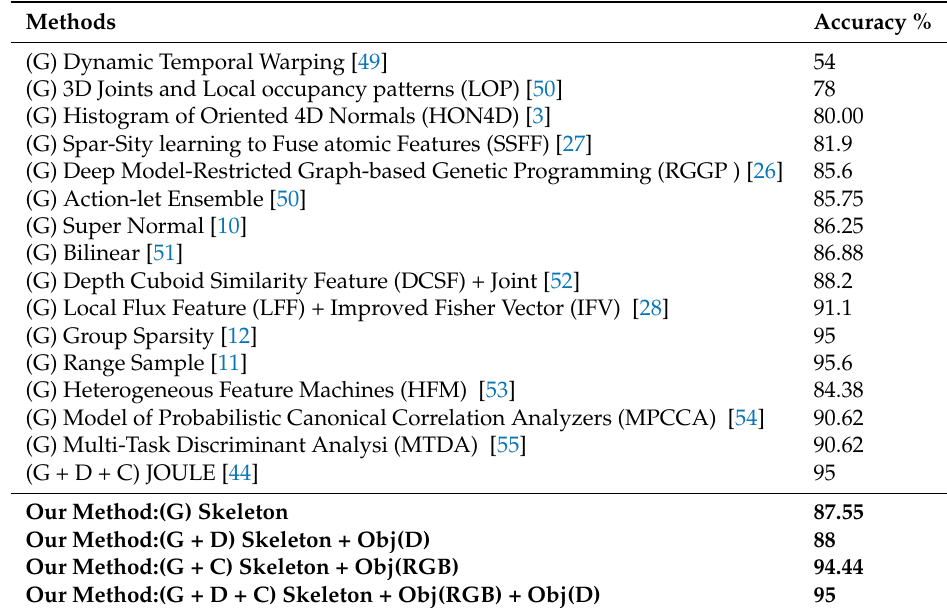
Table 4. Recognition performance on the MSR-DailyActivity3D dataset for different feature spaces: (D) depth; (C) color (or RGB); (G) geometry or